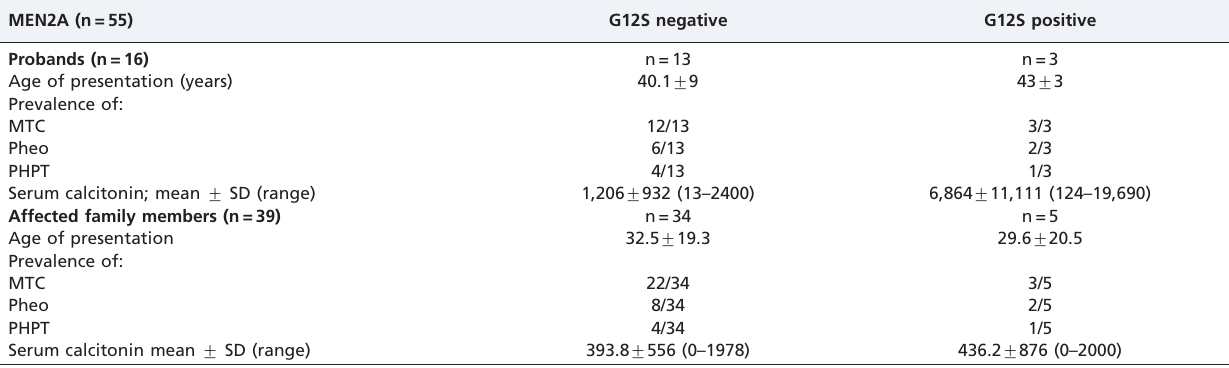
SD = standard deviation; MEN2A = multiple endocrine neoplasia type 2A; MTC = medullary thyroid cancer; Pheo = pheochromocytoma; PHPT = primary